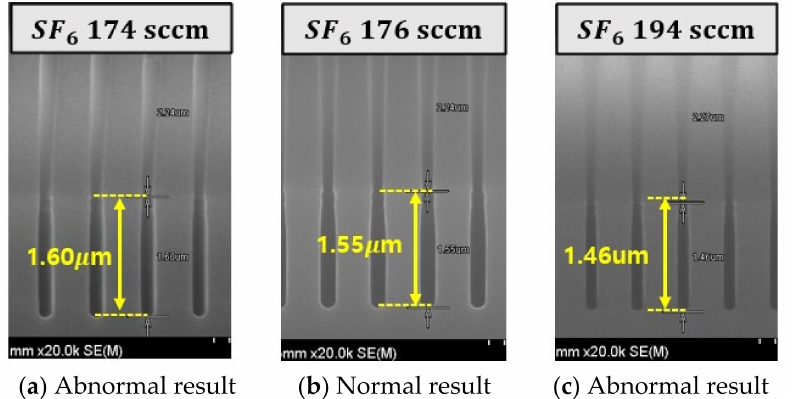
Figure 4. ( a , c ) Abnormal result from the non-BKM recipe; ( b ) normal result from the BKM recipe. Using the aforementioned equipment SVID and OES data, we first selected the key features that were sensitive to changes in the flow rate of the SF 6 gas. Second, using the selected key features and acquired dataset, we compared the accuracies and speeds of the IF and EIF models. Finally, we investigated whether the electron-temperature-related features calculated from the OES datasets could aid detection of process/equipment faults in terms of plasma parameter metrics, as shown in Figure 5.